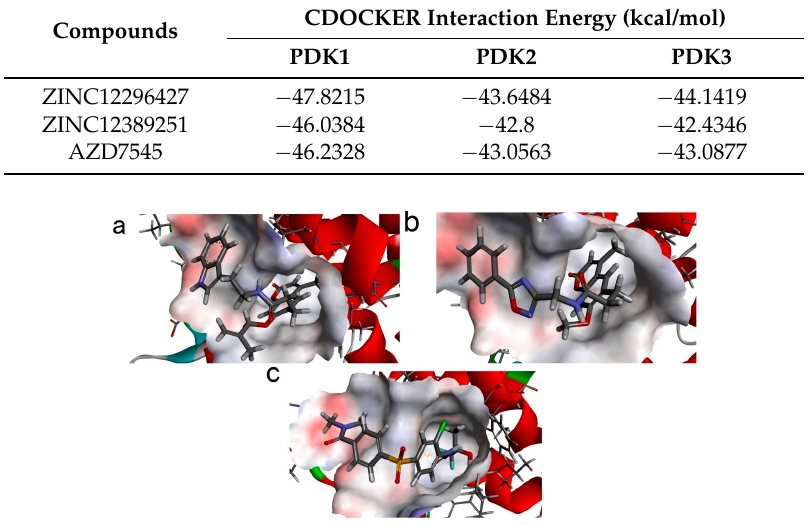
Figure 2. Schematic drawing of interactions between inhibitors and PDK1. The surface of lipoamide-binding pockets are shown, blue represents positive charge, red represents negative charge. Inhibitors are shown in sticks. ( a ) ZINC12296427-PDK1 complex; ( b ) ZINC12389251-PDK1 complex; ( c ) AZD7545-PDK1 complex.